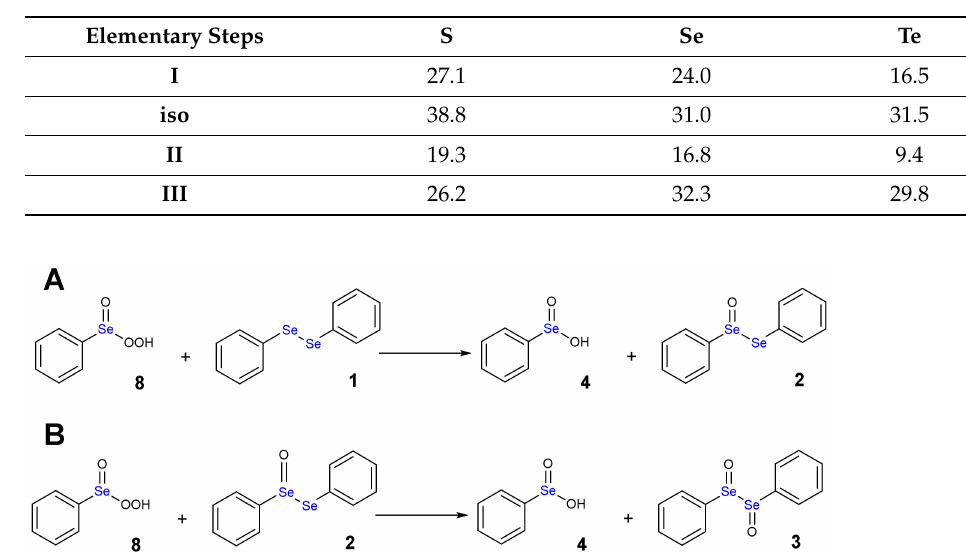
Table 1. Energy barriers for the oxidation of phenylchalcogenols by H 2 O 2 (Scheme 9A). Level of theory: ZORA-OLYP/TZ2P. Data taken from